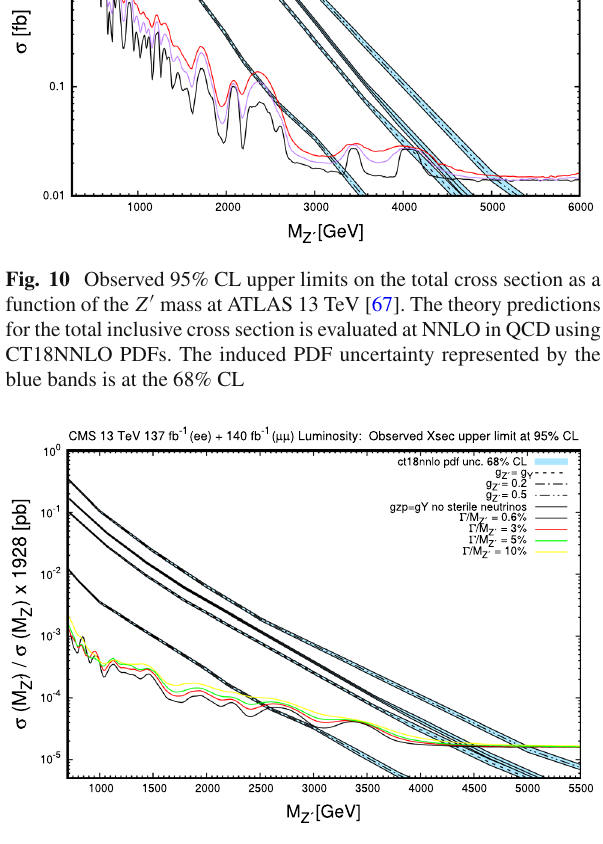
Fig. 11 Observed95%C.L.upperlimitsonthetotalcrosssectionratio asafunctionofthe Z (cid:2) massatCMS13TeV[69].Thetheorypredictions are evaluated as in Fig. 10